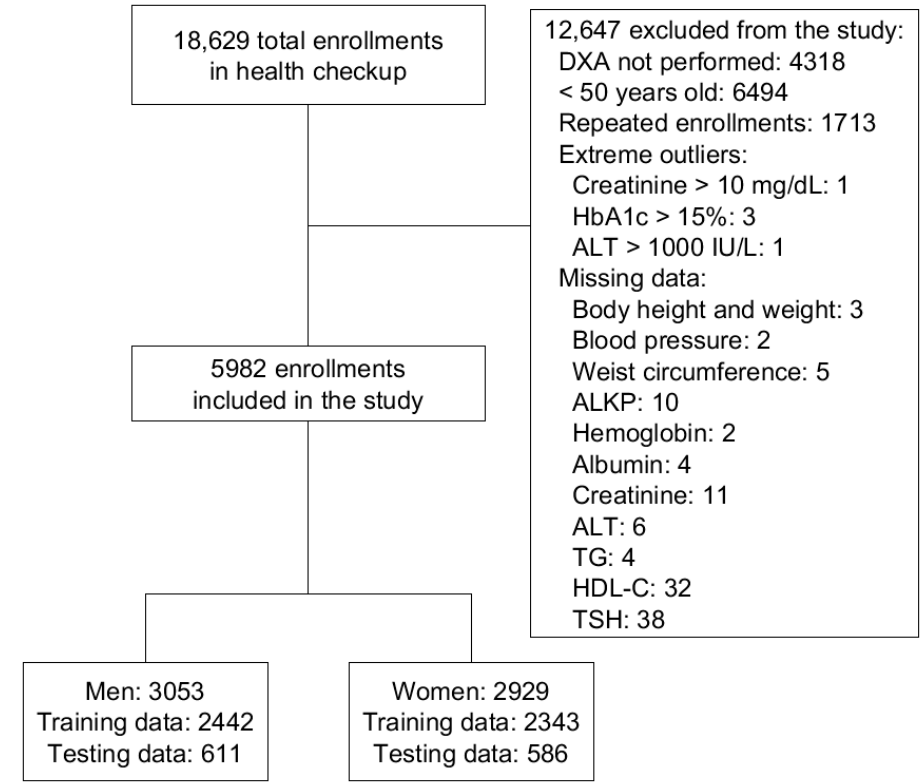
Figure 1. Flowchart of data inclusion and preprocessing. DXA: dual-energy X -ray absorptiometry; HbA1c: Hemoglobin A1c; ALT: alanine transaminase; ALK-P: alkaline phosphatase; TG: triglyceride; HDL-C: high-density lipoprotein cholesterol; TSH: thyroid-stimulating hormone.